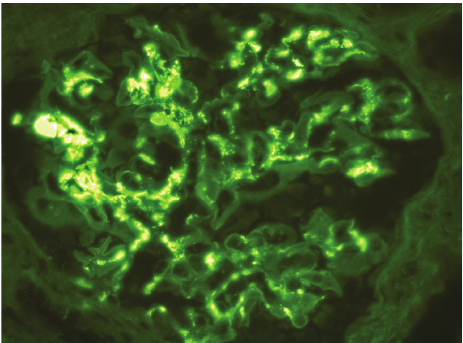
Figure 2: The immunofluorescence microscopy shows IgA deposits in the glomerular mesangium (magnification ×